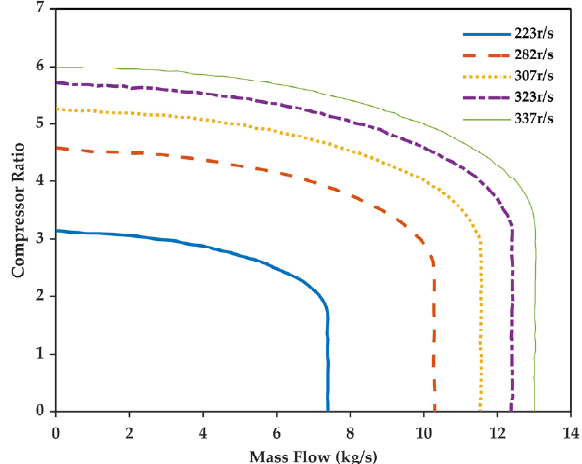
Figure 3. Character flow curve of compressor.